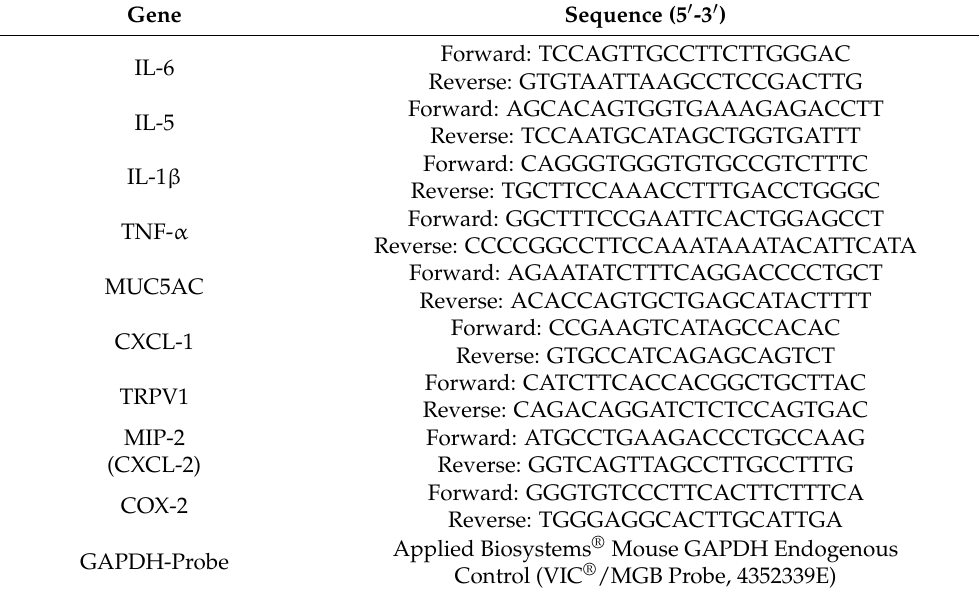
Table 2. The primer and probe